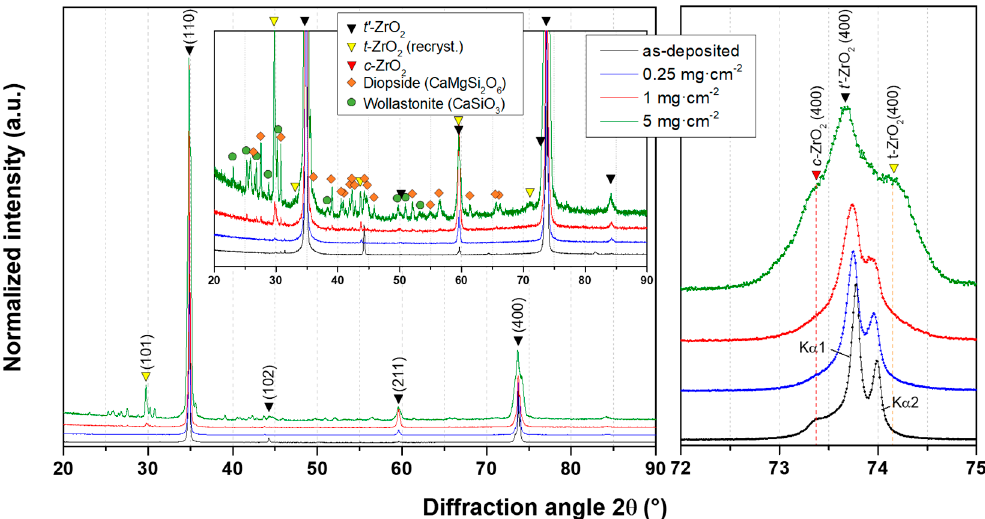
Figure 9. X-ray diffractograms of the co-stabilised ErYSZ coatings in their as-deposited conditions and after annealing in air at 1250 °C for 1 h with different amounts of CMAS deposit.